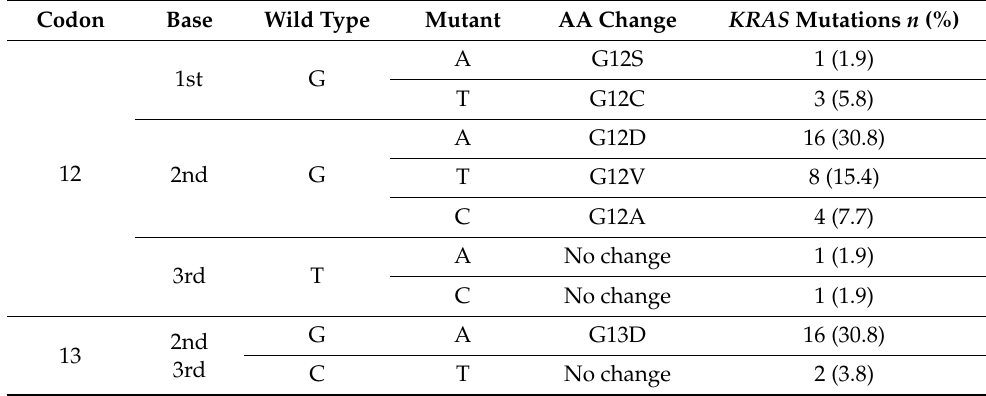
Table 1. Distribution of KRAS mutations in codons 12 and 13 of exon 2 (N = 52).